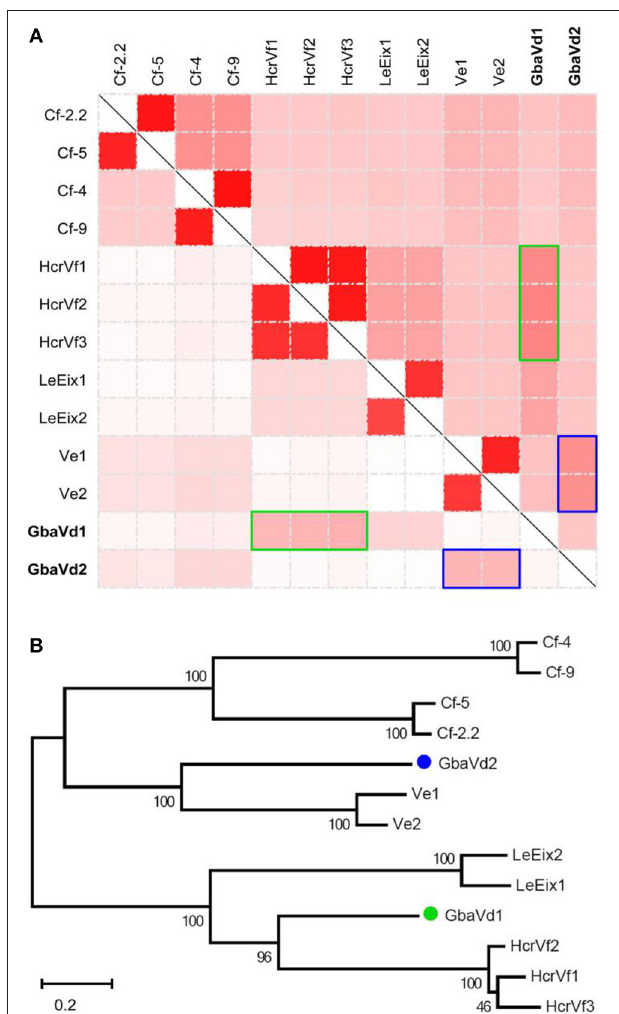
FIGURE 1 | Analysis of GbaVd1 and GbaVd2 sequence characteristics. (A) Homology analysis of GbaVd1 and GbaVd2 with known RLPs. The upper-right and bottom-left represent identical nucleotide and encoding protein sequences among RLPs, respectively. The colors, from white to red, represent the percentage identities, from 0 to 100%. The green and blue rectangles represent the best hits of RLPs with GbaVd1 and GbaVd2 , respectively. (B) Phylogenetic tree of GbaVd1 and GbaVd2 with homologs from other plant species. The analysis was performed using the package MEGA6 with the Maximum Parsimony